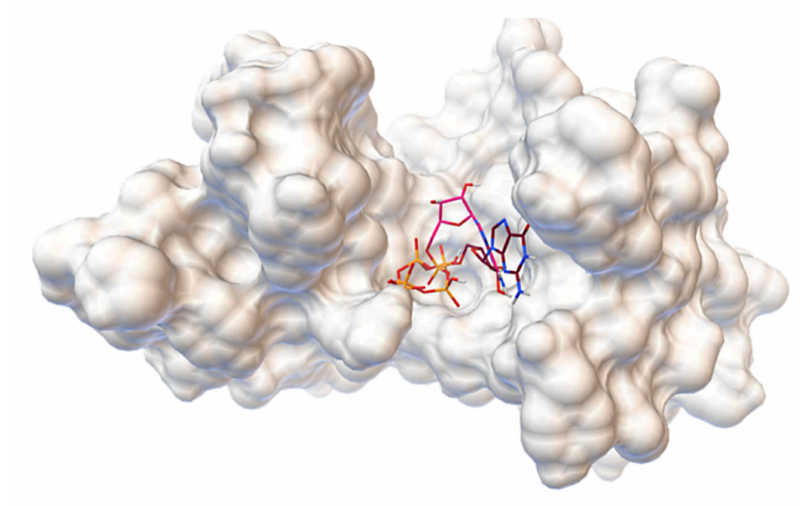
Figure 1. The 3D structure of SpoT domain exhibiting kinase activity with ATP and GTP bound to the common cavity.